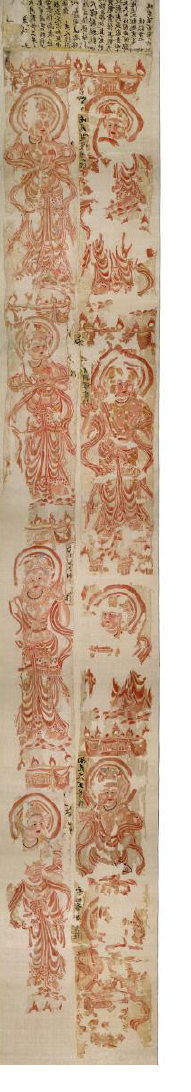
Figure 1. Long Banner of Bodhisattvas (Stein Painting 216), 956 CE, ink and colors on silk, H. 396.0 cm, W. 59.0 cm, 1919,0101,0.216, British Museum. © The Trustees of the British Museum.